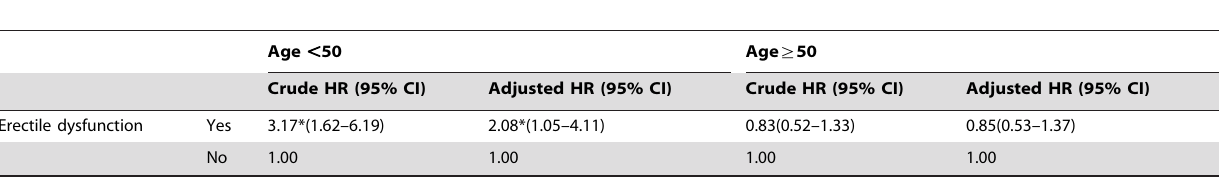
Table 3. Crude and adjusted hazard ratios (HR) for the development of end stage renal disease (ESRD) requiring dialysis among the sample patients stratified by age.